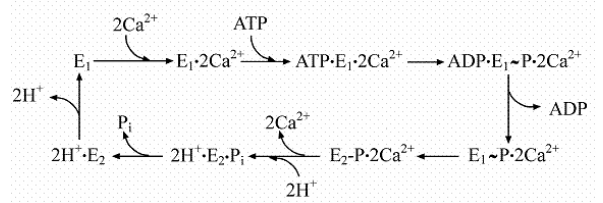
Figure 4. Diagram outlining the sequential reactions of a Ca 2+ ATPase cycle at neutral pH. The cycle starts with the enzyme in basal conformation, with H + bound at the specific Ca 2+ exchange site (2H . E 2 ). Upon H + dissociation, 2Ca 2+ bind and the enzyme is activated (E 1 . 2Ca). ATP then leads to formation of the high poten- tial phosphorylated intermediate (ADP . E 1 * P . 2Ca). Following dis- sociation of ADP, the phosphorylated intermediate uses its poten- tial for a conformational change reducing affinity and orientation of bound calcium. 2 Ca 2+ are then dissociation in exchange for 2 H + . The residual phosphoenzyme then undergoes hydrolytic cleav- age with release of Pi, and returns to the basal conformation with H + bound (2H . E 2) . The stoichiometry of H + binding is 2 per E at neutral pH. At high pH, less or no H+ exchanges for Ca 2+ . Thereby Ca 2+ is not released before Pi cleavage, and the enzyme undergoes an uncoupled cycle. Figure 5. ATP dependent Ca